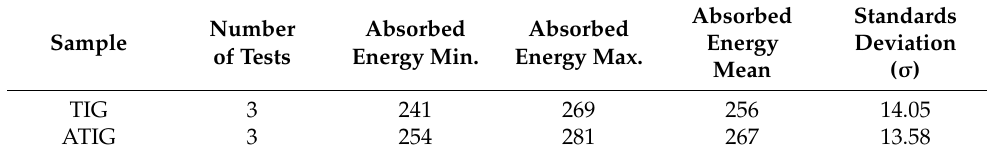
Table 13. Energy absorbed (J/cm 2 ) and standard deviation of TIG and ATIG at fusion zone.